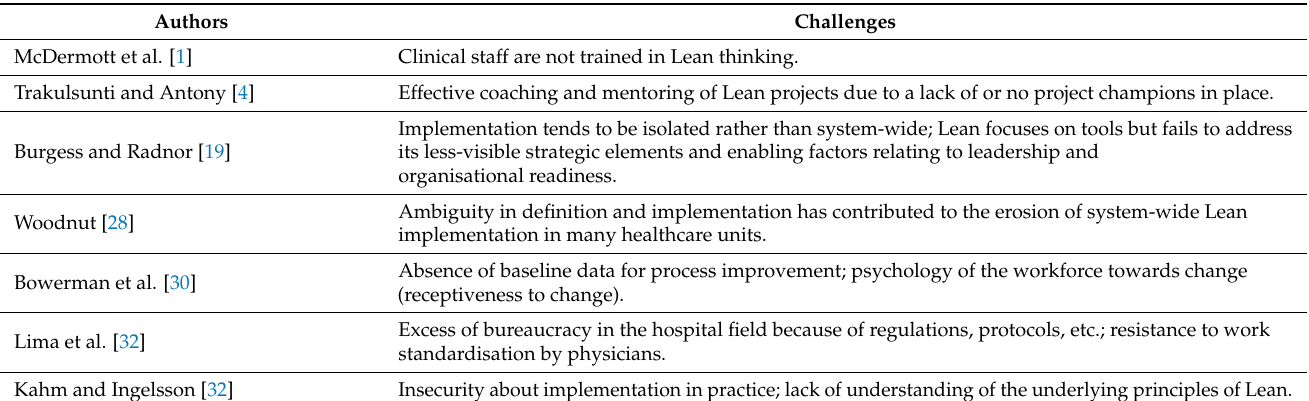
Table 3. Challenges related to LSS in